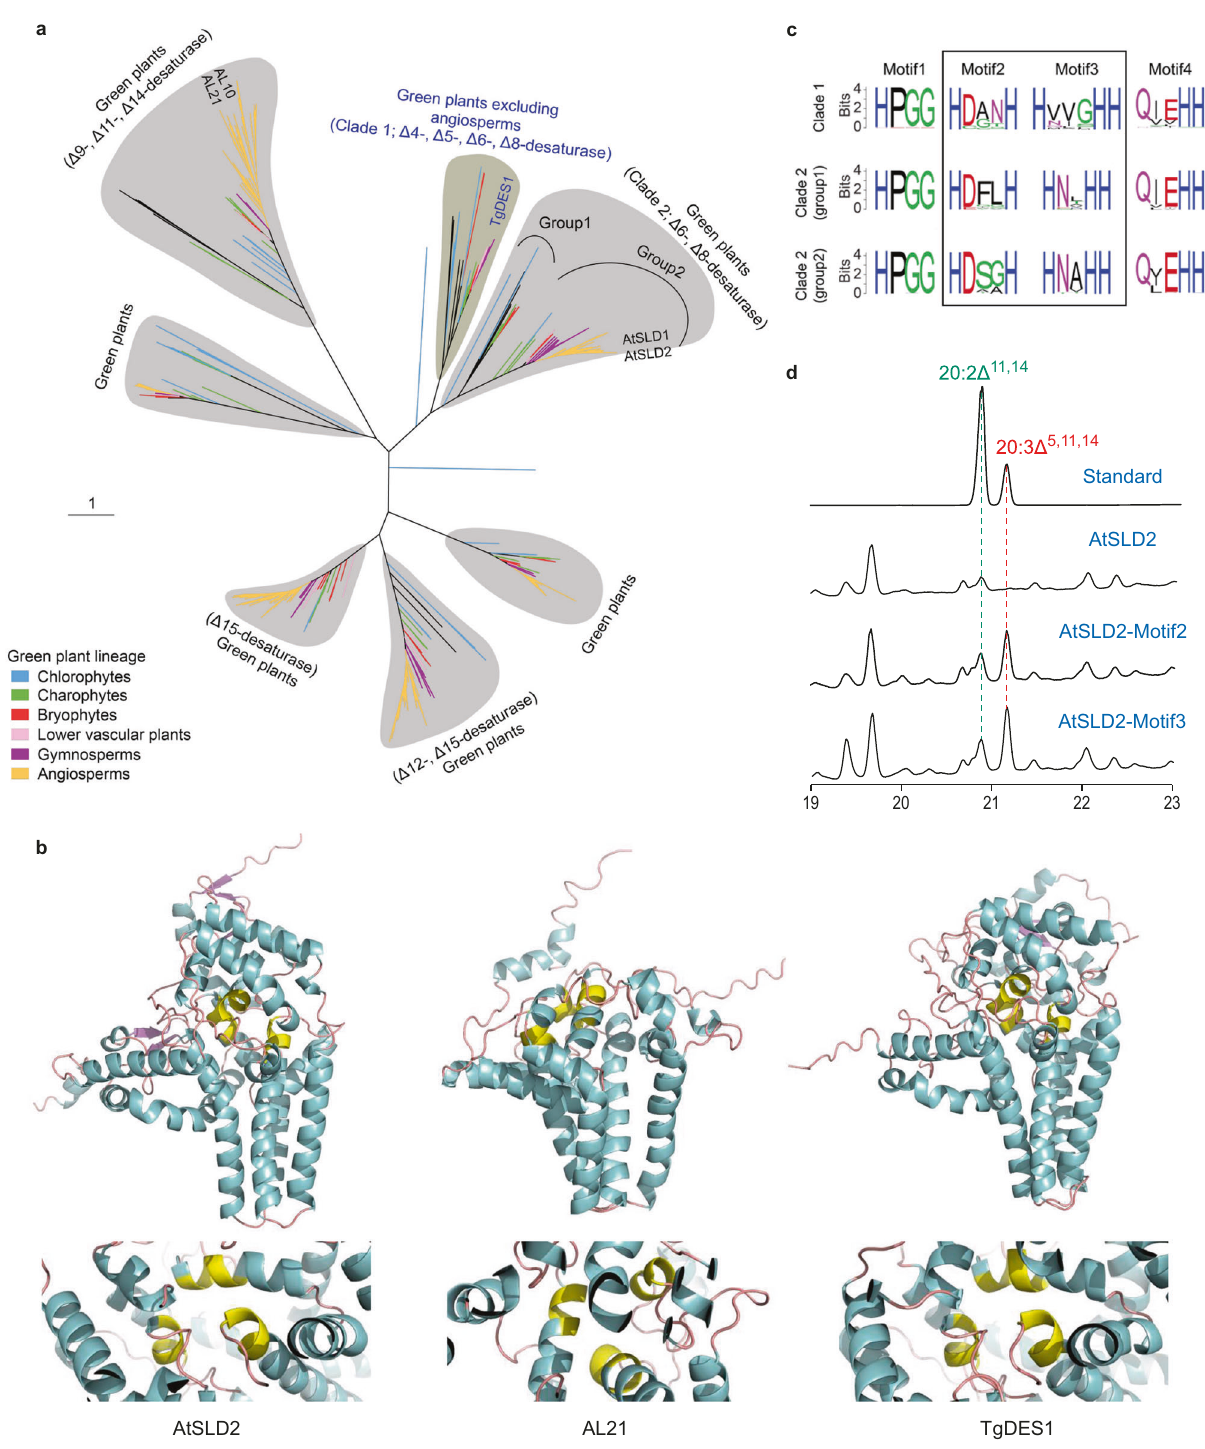
Fig. 4 | Origin and evolution of plant Δ 5 -desaturases. a Maximum likelihood phylogeny of plant desaturases. TgDES1 is clustered within a group (clade 1) close toasisterclade(clade2)comprising Δ 6 -and Δ 8 -desaturases. b Structuremodeling of TgDES1 and the desaturases from Arabidopsis (AtSLD2) and Anemone leveillei (AL21). Protein structures were modeled with AlphaFold2 and the bioactive center of each protein comprising three histidine-rich motifs is marked with yellow.